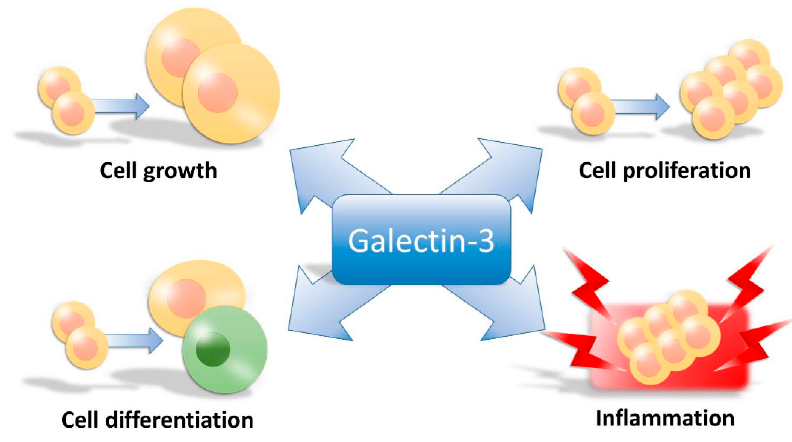
Figure 1. The action of galectin-3 in the cells.